Question: Express in one sentence what the figure is showing.
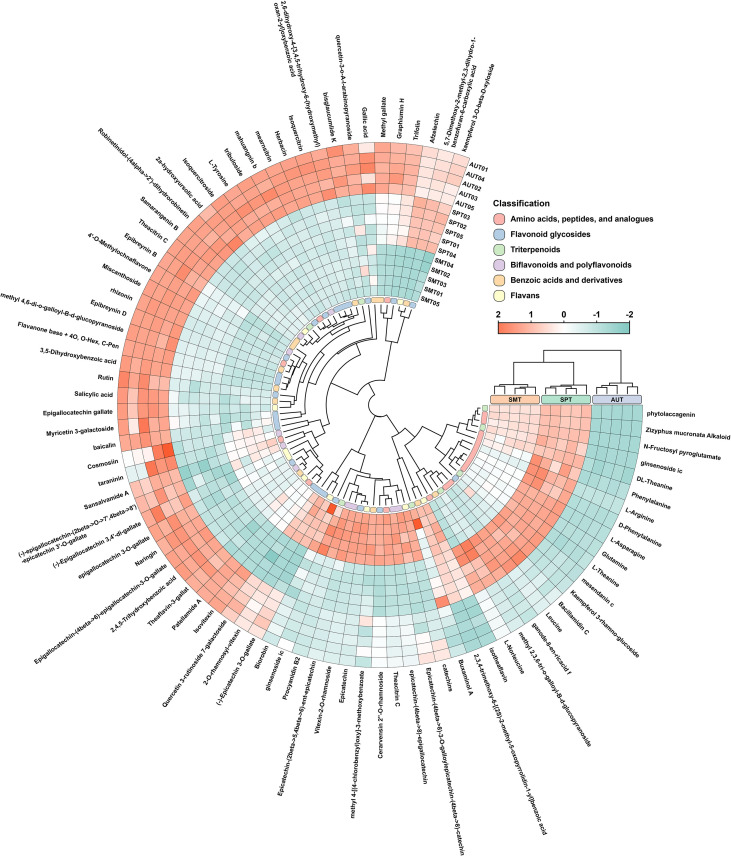
Answer: Heatmap clustering analysis of 82 key differential non-volatile metabolites in GBTs harvested in different seasons.